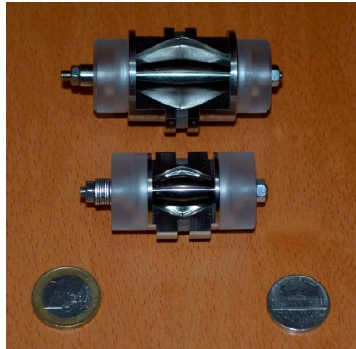
Figure 2. Two Orbitrap analyzers with both a 1-Euro coin and an American nickel as a reference for size [24]. The smaller device is the newer ultra-high resolution Orbitrap analyzer.